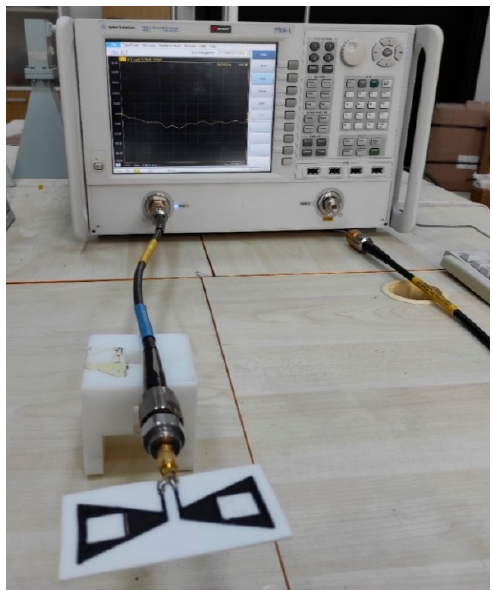
Figure 7. Measurement setup by using Keysight Technologies’ PNA-L Agilent vector network ana-